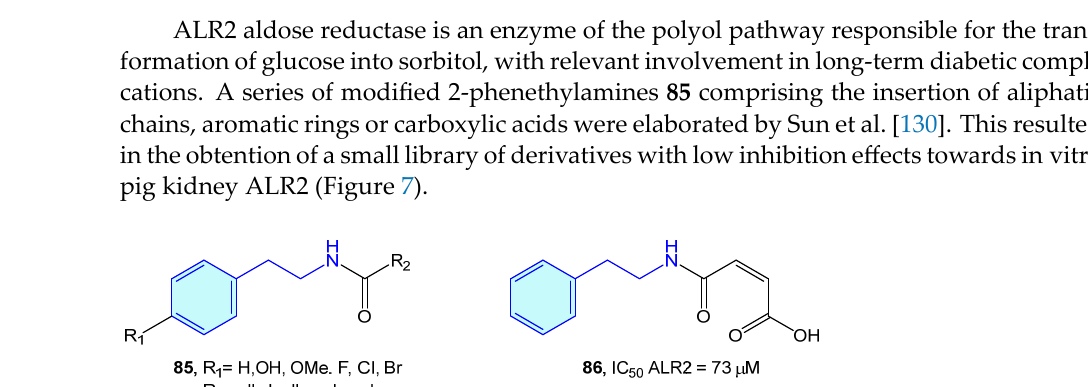
Figure 7. 2-Phenylethyl-based ALR2 ligands by Sun et al [130].